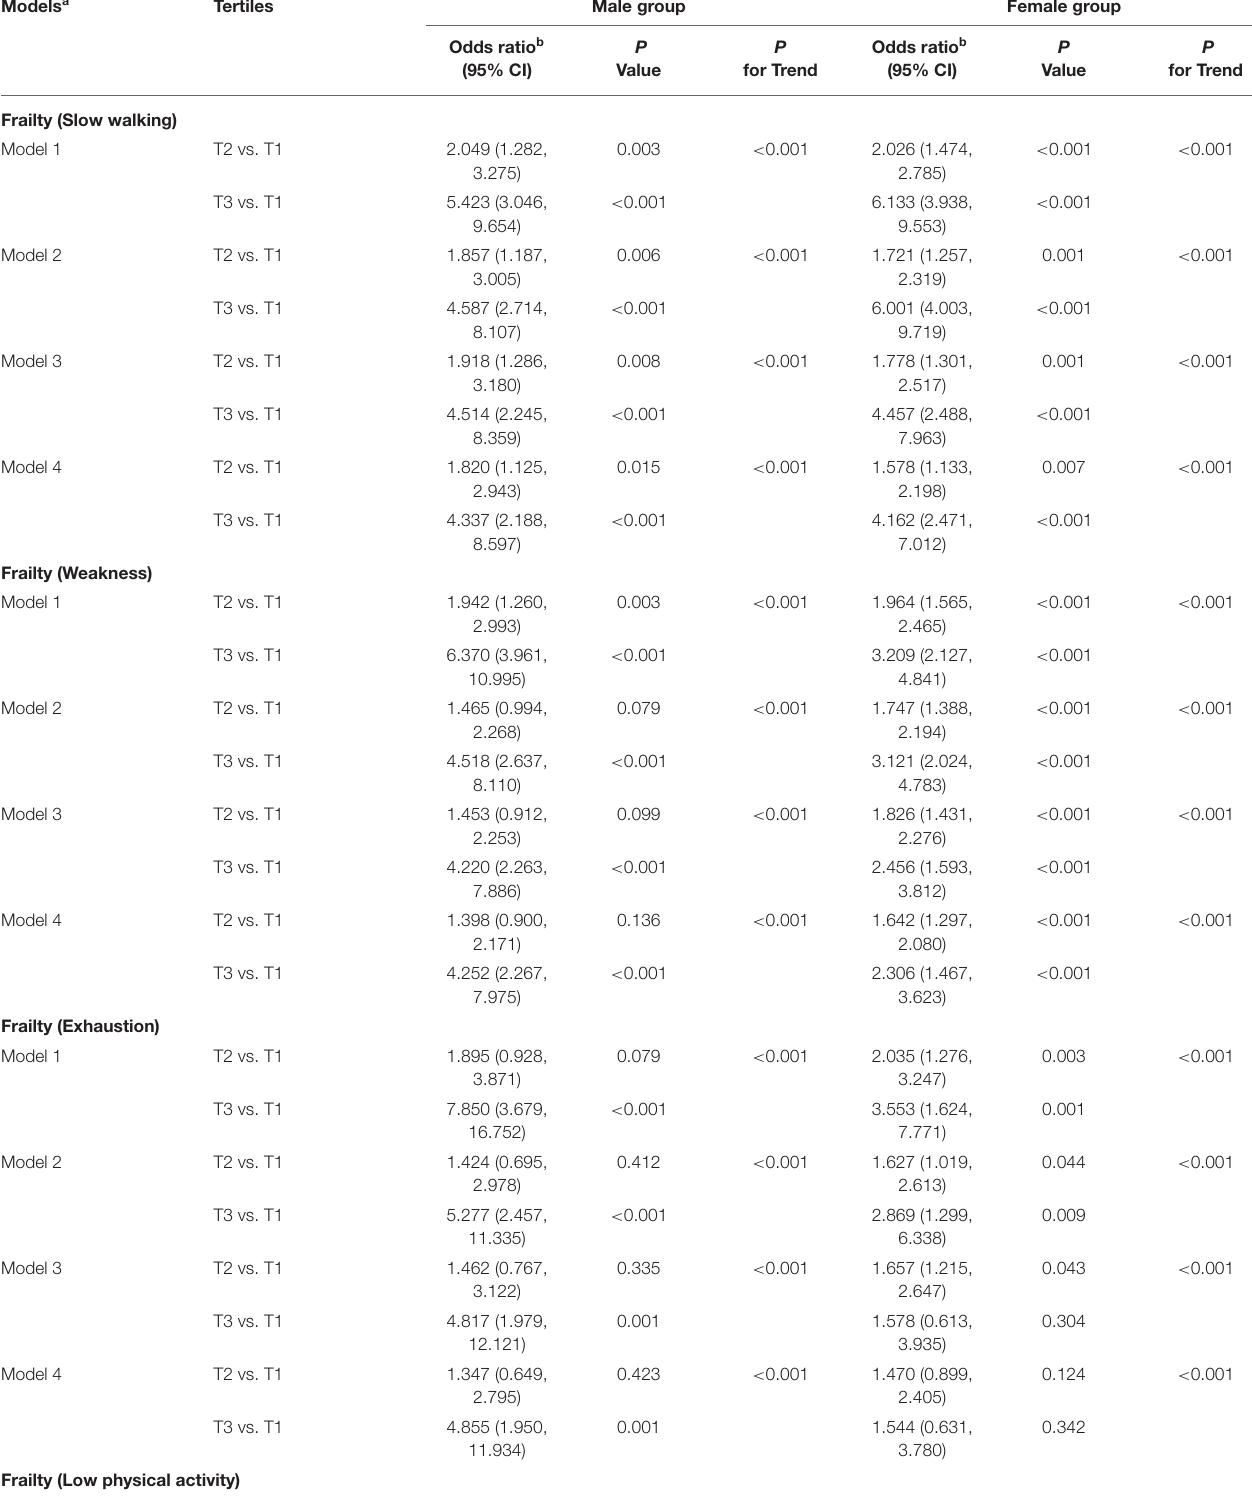
TABLE 3 | Association between the frailty components and proteinuria in male and female participants with metabolic syndrome. Models